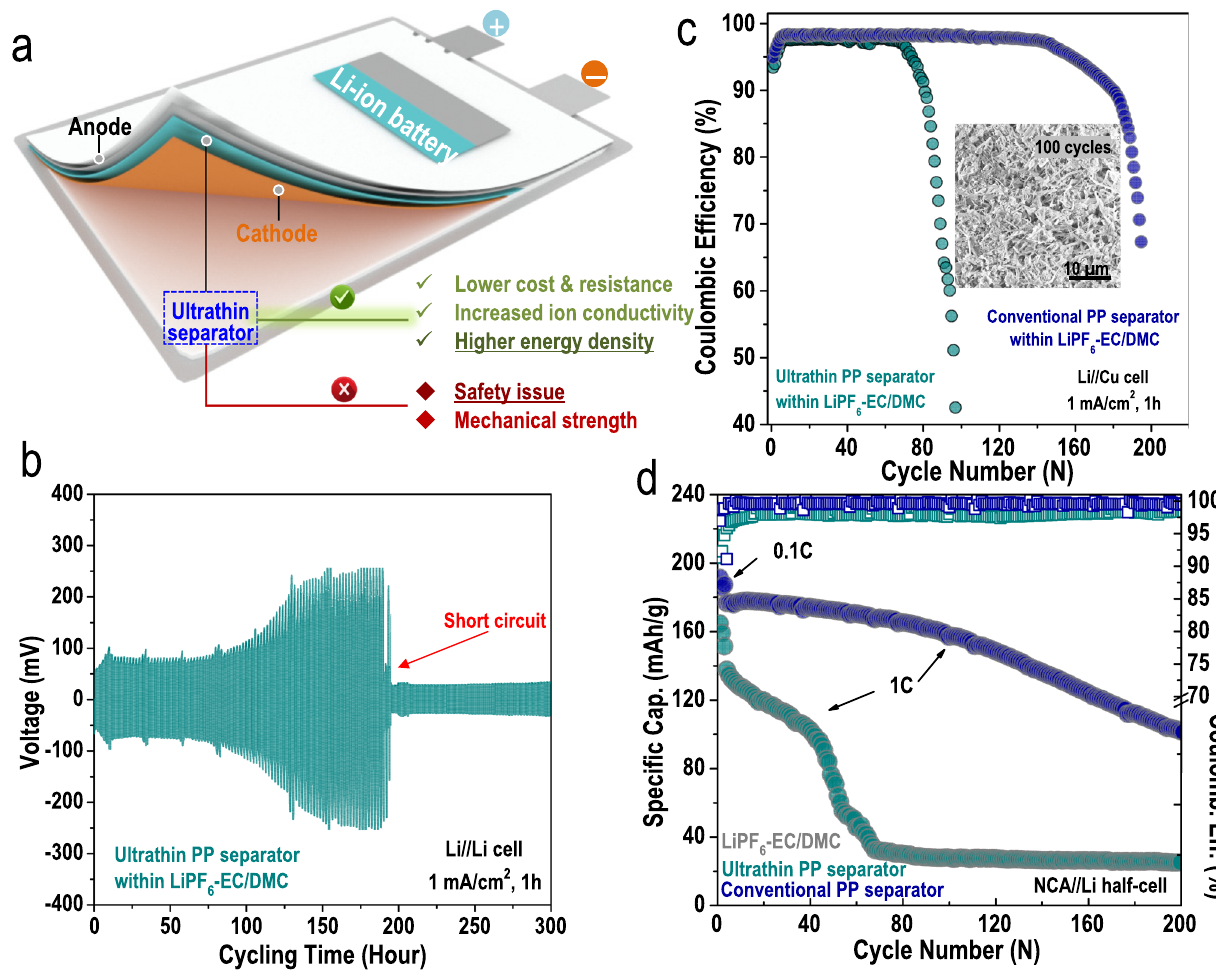
Fig. 1 | Conventional ultrathin separators (8 µ m thickness) are excluded from useinlithium-metalbatteries.a Schematicrepresentationof the advantagesand disadvantagesofaconventionalultrathinseparatorinconstructingaLi-ionbattery system. Li-metal plating/stripping reversibility evaluated by b Li||Li symmetric cell and c Coulombic ef fi ciency (CE) of a Li||Cu half-cell assembled with an ultrathin separator (8 µ m thickness) and conventionalseparator(20 µ m thickness)